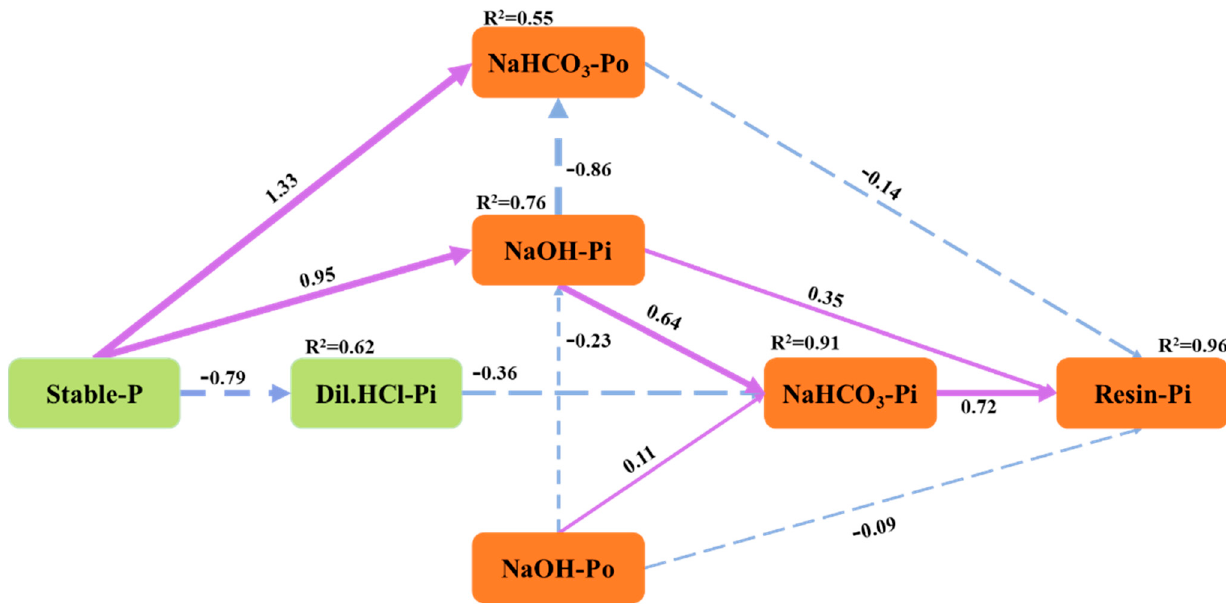
Figure 3. Structural equation model (SEM) exhibiting the transformation among different soil P fractions following fertilization regimes. The standardized path coefficients are marked on the arrows. Arrow width represents the strength of the path coefficient. The overall fit of the model: χ 2 = 7.27, P = 0.51, CFI = 1.00 RMSEA = 0.00 SRMR = 0.03. Sum of conc.HCl-Pi, conc.HCl-Po and residual P indicate a stable P pool.